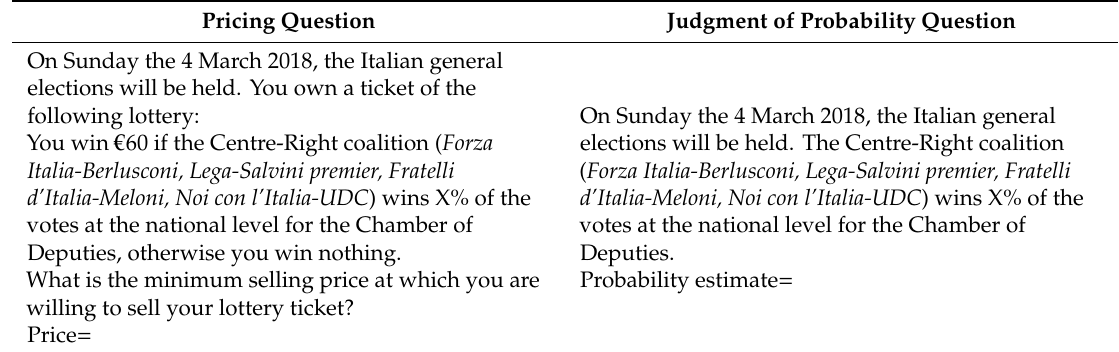
Table 1. Uncertain lotteries for Milan